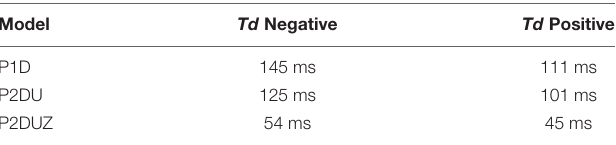
TABLE 3 | Mean delay values for supraliminal step changes ( ± 115 bpm or larger) as estimated by three models, extracted from aggregated data over three